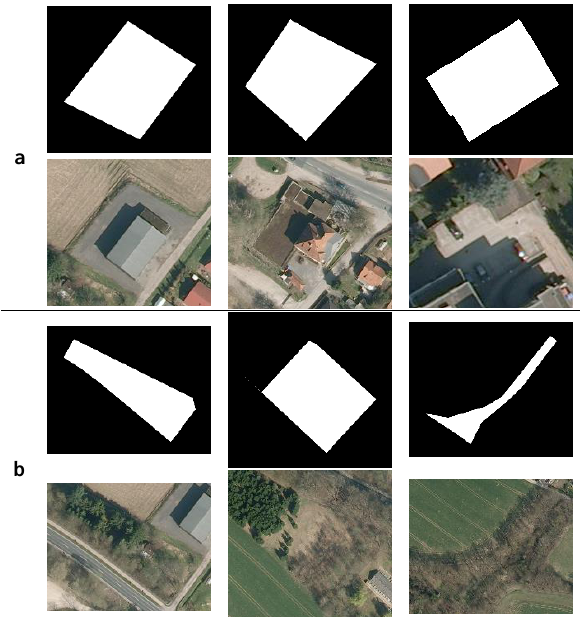
Figure 5: Similar land use objects in category level II with polygon masks (binary images) and DOP (RGB). From left to right in group a : mixed used area, industry area, parking lot ; From left to right in group b : recreation area, grove, forest. The images are rescaled for visualization.